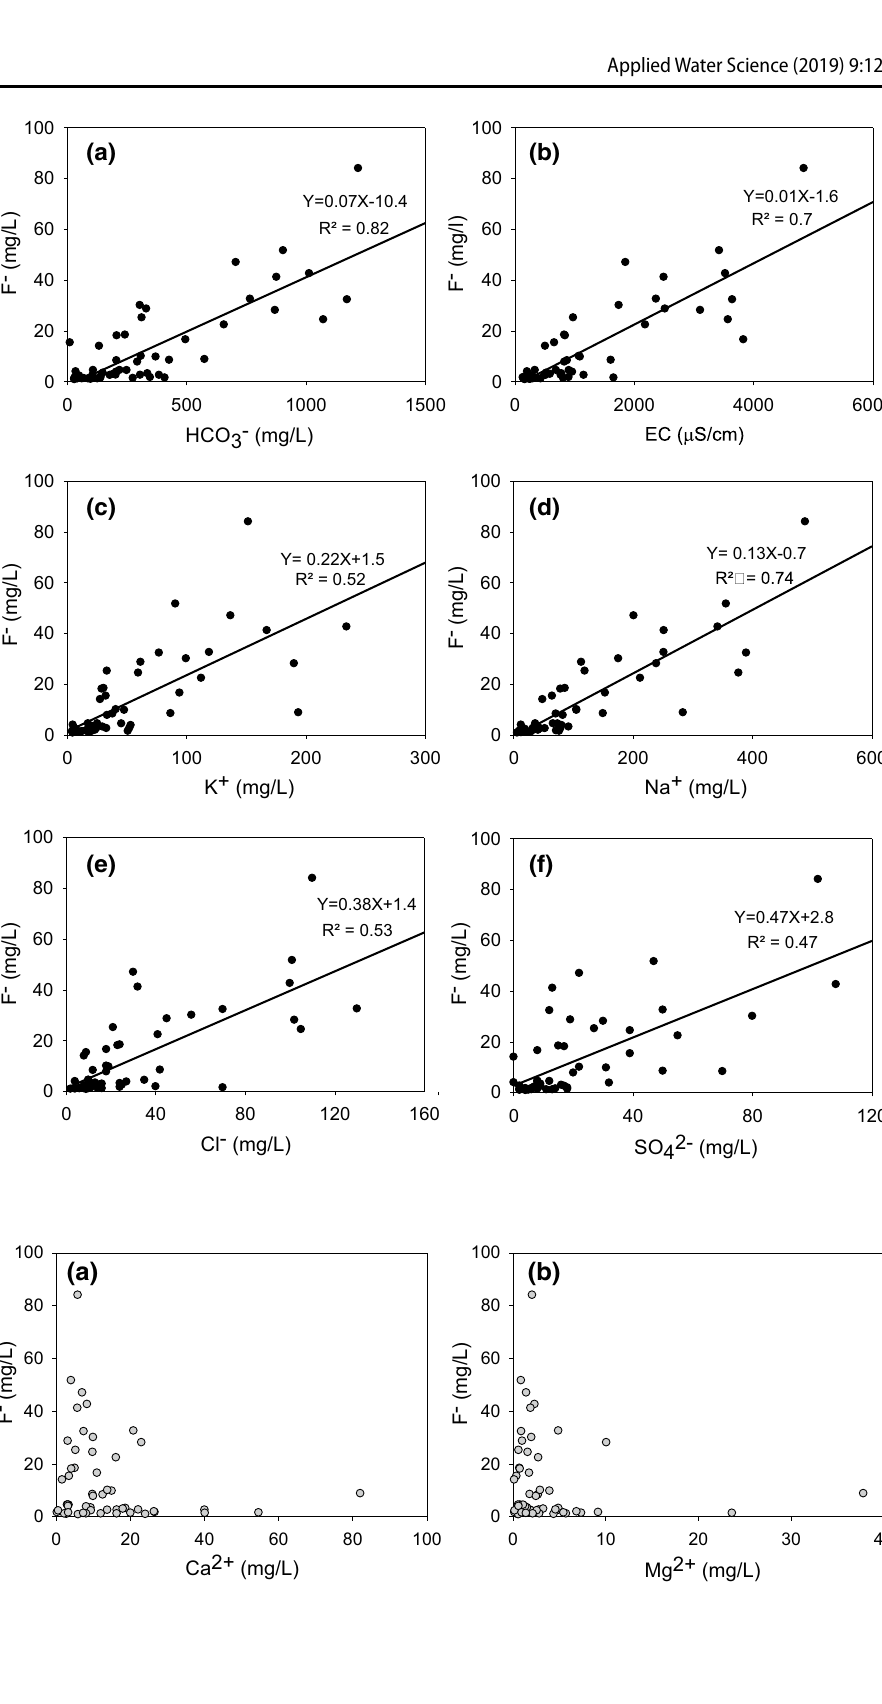
Fig. 11 Positive correlation of fluoride with a HCO 3− , b EC, c K + , d Na + , e Cl − and f SO 42−